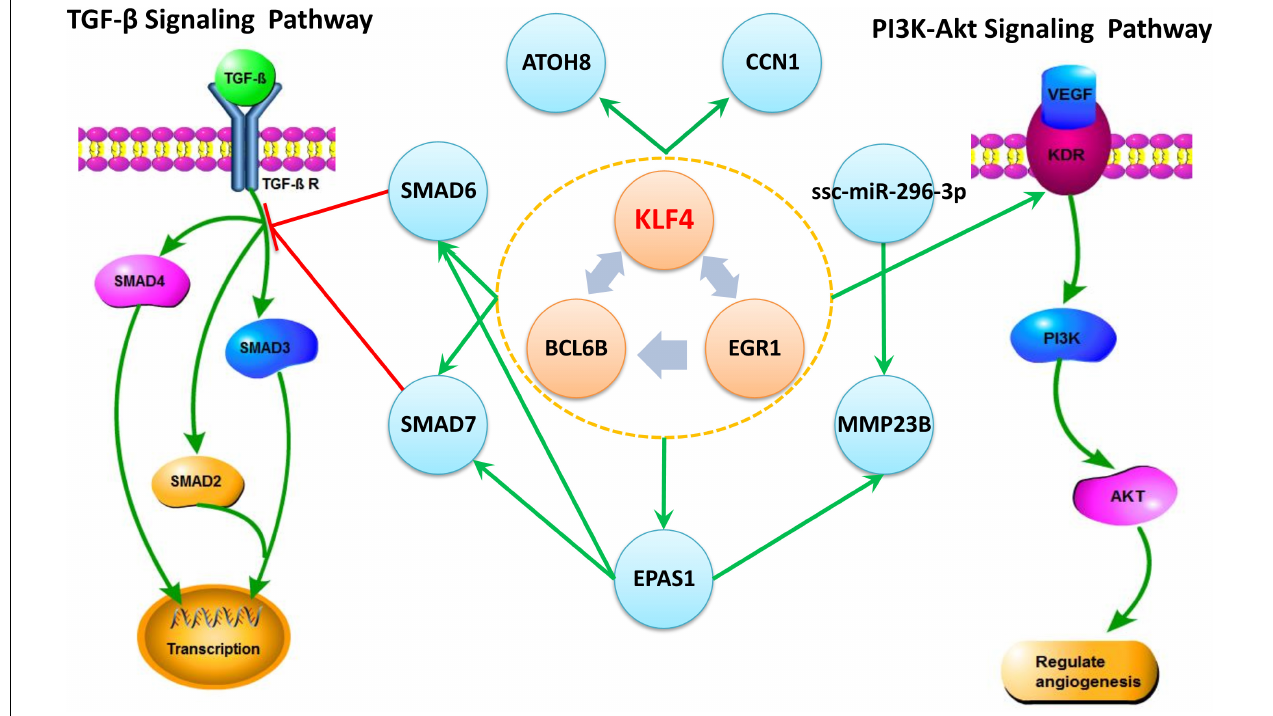
FIGURE 7 | The “KLF4–EGR1–BCL6B” complex and their regulated genes in Tibetan pig lung tissues. The complex formed by KLF4–EGR1–BCL6B regulates the EPAS1 , SMAD6 , SMAD7 , KDR , ATOH8 , and CCN1 genes and mediates the TGF- β and PI3K-Akt signaling pathways by regulating SMAD6 , SMAD7 , and KDR genes, respectively. The green edge in the figure represents regulation, and the red edge represents